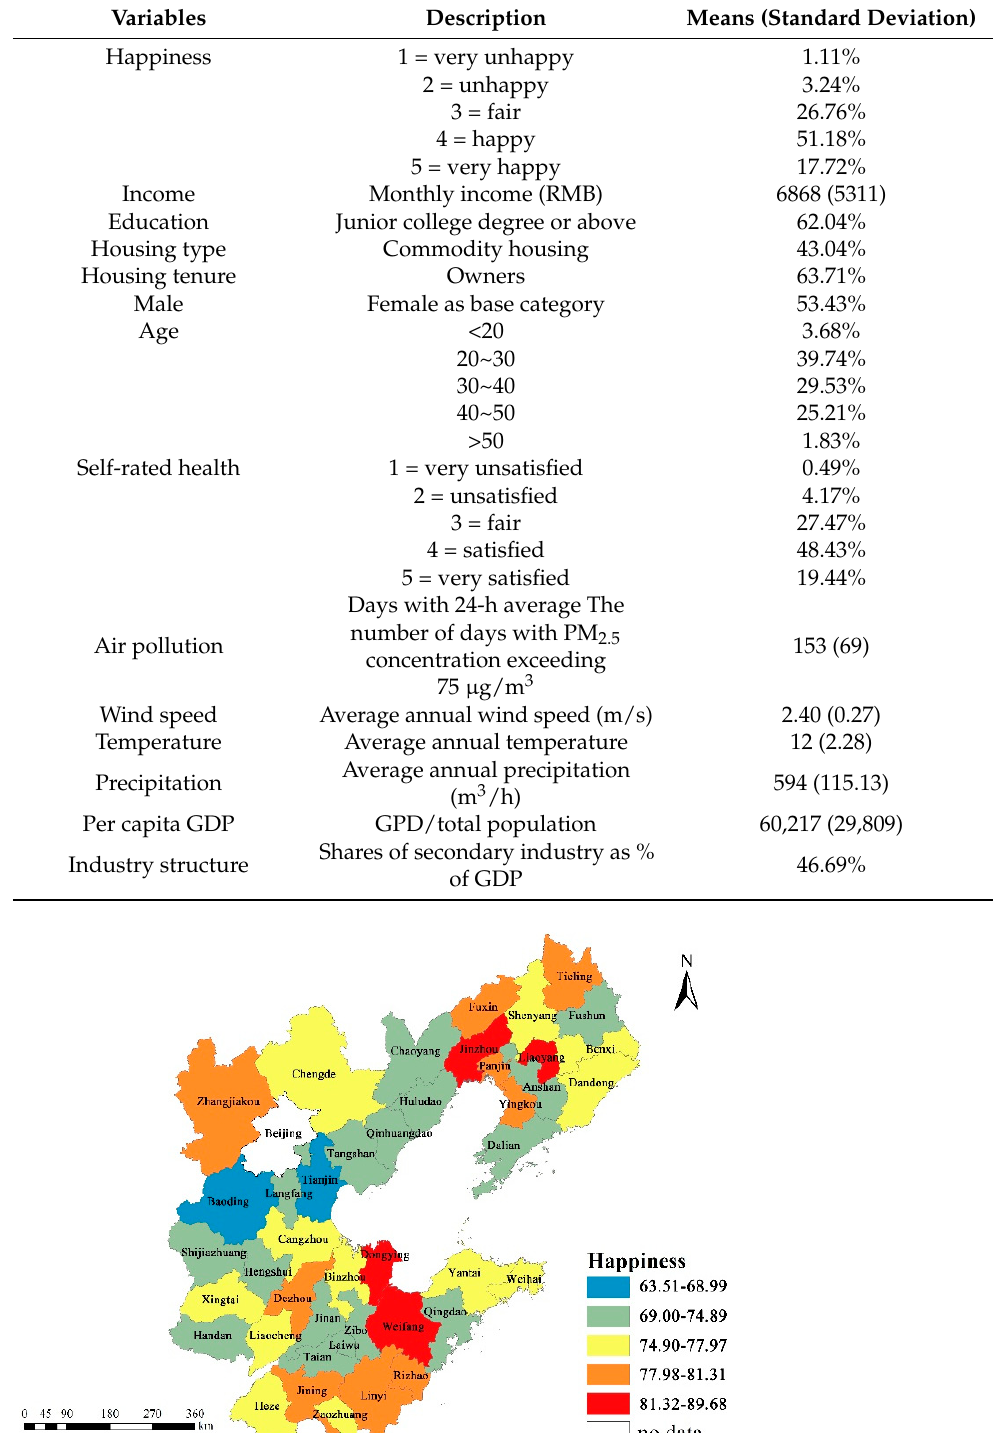
Table 1. Descriptive summary of variables in the analysis.